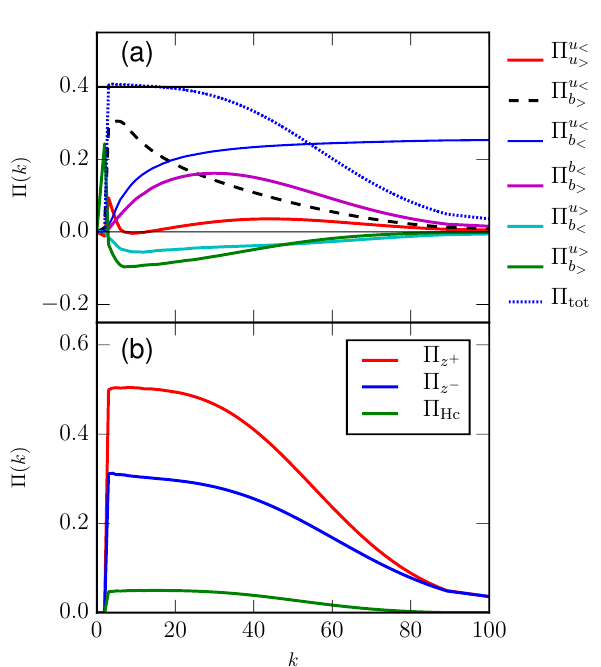
Figure 4. Plots of various fluxes in MHD turbulence ( a ) Π u < u and ( b ) Π z + , Π z the total-energy injection